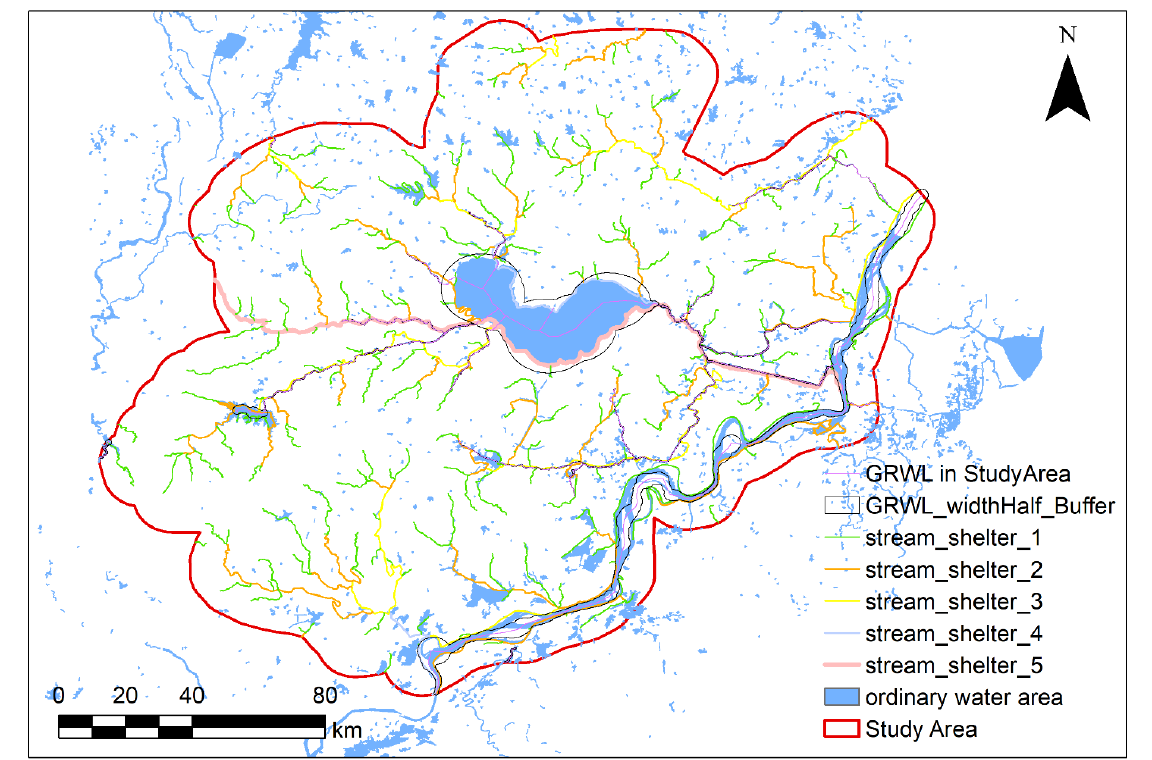
Figure 17. The distribution of GRWL in the study areas, overlaid by the digital streams derived by DEM, and the common water area in the study area. DEM, and the common water area in the study